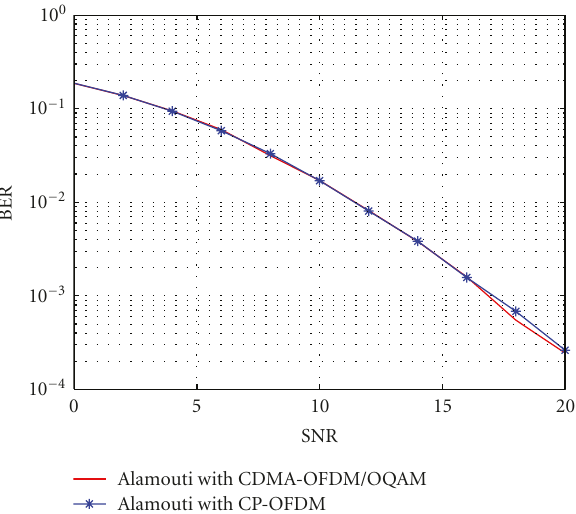
Figure 7: BER for the complex version of the Alamouti CDMA- OFDM/OQAM with spreading in frequency domain, versus Alam- outi CP-OFDM for transmission over a flat fading